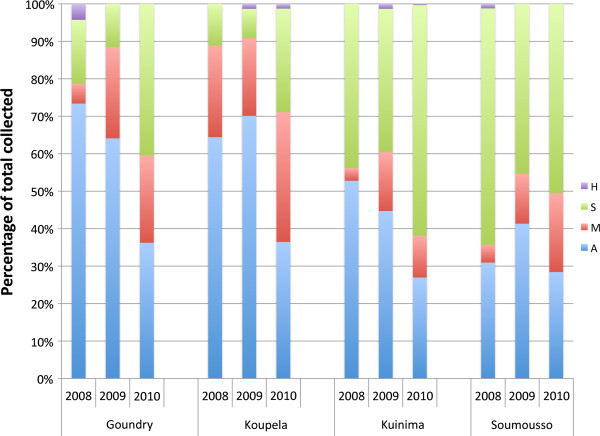
Species identification within Anopheles gambiae s.l. for the four sentinel sites in 2008–2010. Data are presented as proportions of the total for each species, An. arabiensis (A), An. gambiae M form (M), An. gambiae S form (S) and the hybrid of M and S forms (H), by year and by site. Sample sizes are minimum of 75 per site for 2008 and 2009 and a minimum of 309 for 2010.